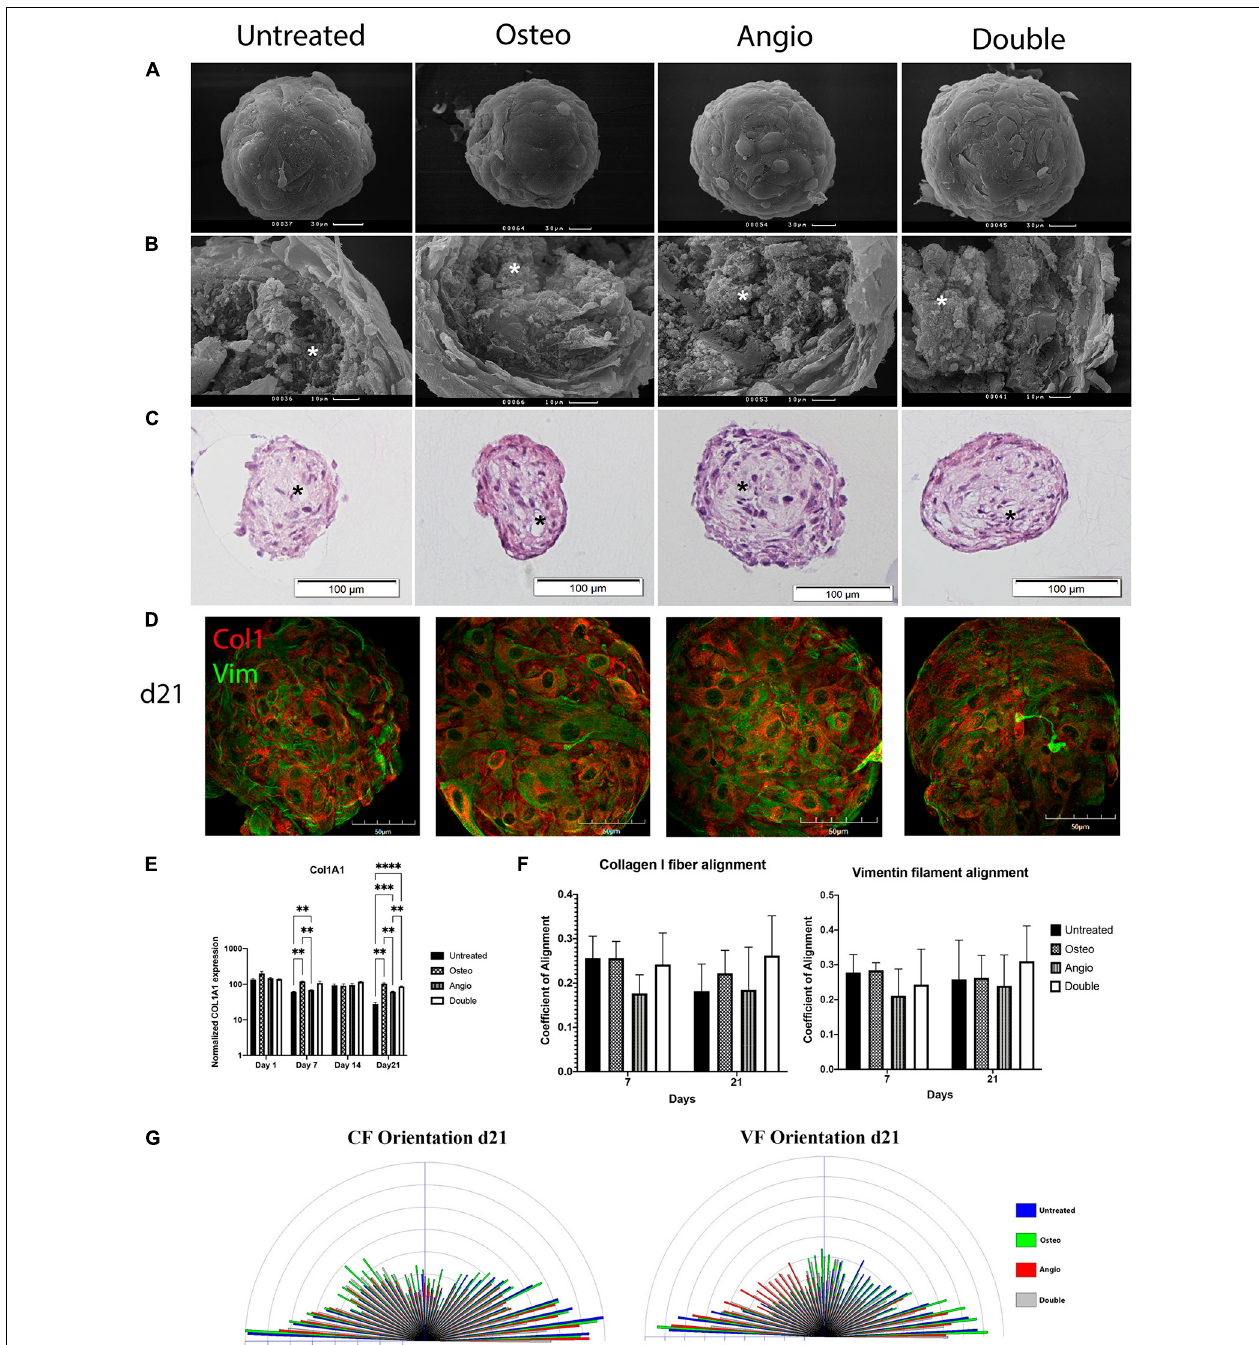
FIGURE 5 | Untreated and treated ADSC-derived spheroids developed identical morphology by day 21 in 3D culture. (A) ADSCs aggregated in compact spheroids with a smooth surface formed by hexagonal-shaped cells; scale bar 30 µ m. (B) Cracked spheroids revealed the layered structure of the surface and the central core composed of fibrils and bundles of extracellular matrix labeled by white asterisks; scale bar 10 µ m. Scanning electron microscopy . (C) Histological H&E staining confirms that the surface of spheroids was formed by a few layers of cells and shows that the core had cavities labeled by black asterisks; scale bar 100 µ m. Bright-field microscopy . (D) The distribution of Col1 (red) and Vim (green) in spheroids on day 21. Laser Scanning Confocal Microscopy, scale bar 50 µ m . (E) Mean ( ± SEM) COL1A1 gene expression levels (normalized to housekeeping genes), two-way ANOVA, ∗∗ p < 0.01, ∗∗∗ p < 0.001, ∗∗∗∗ p < 0.0001. (F) Col1 fibrils and Vim filament alignment coefficients. (G) The distribution and frequency of angles of collagen type I fibrils and vimentin filament orientation.